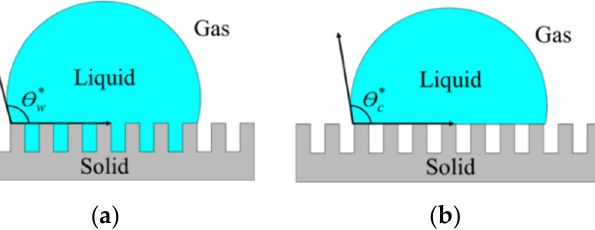
Figure 2. A liquid droplet resting on a solid surface with micro-/nano-structures: ( a ) the liquid is in intimate contact with the solid asperities of the rough surface so that the droplet is in the Wenzel state; ( b ) the liquid rests on top of the asperities of the rough surface so that the droplet is in the Cassie–Baxter state.